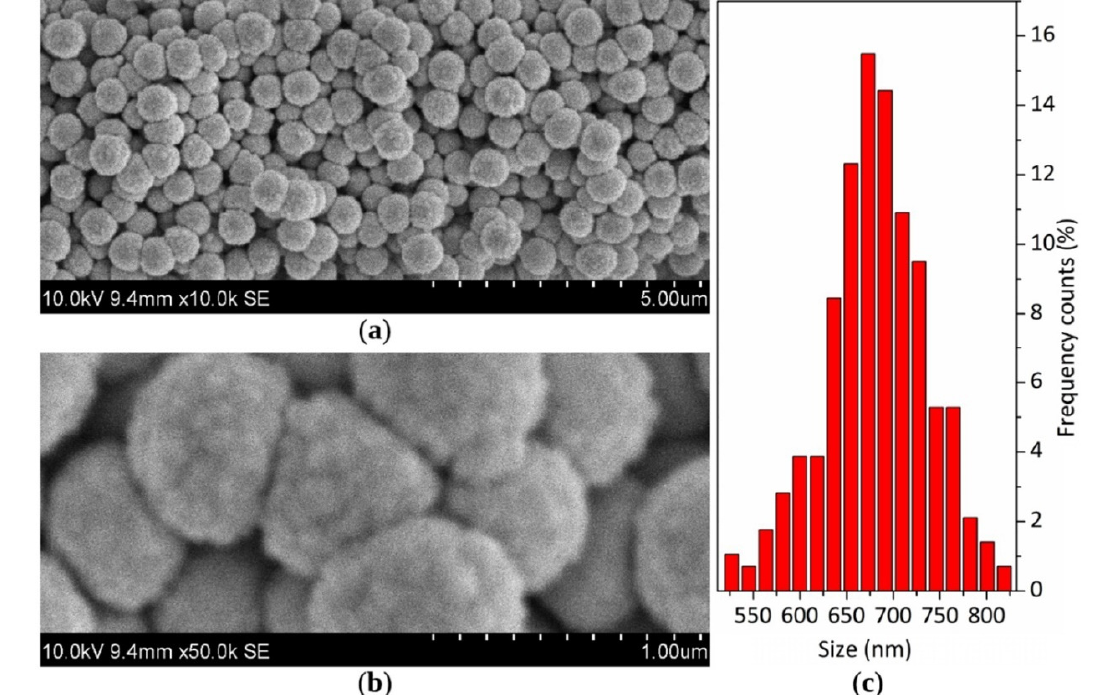
Figure 28. SEM image of SG fabricated SiO 2 –F powder ( a ) with a detailed view on FOTS-functionalized cauliflower-like silica spheres ( b ) and histogram of particle size distribution based on SEM imaging ( c ) [242].